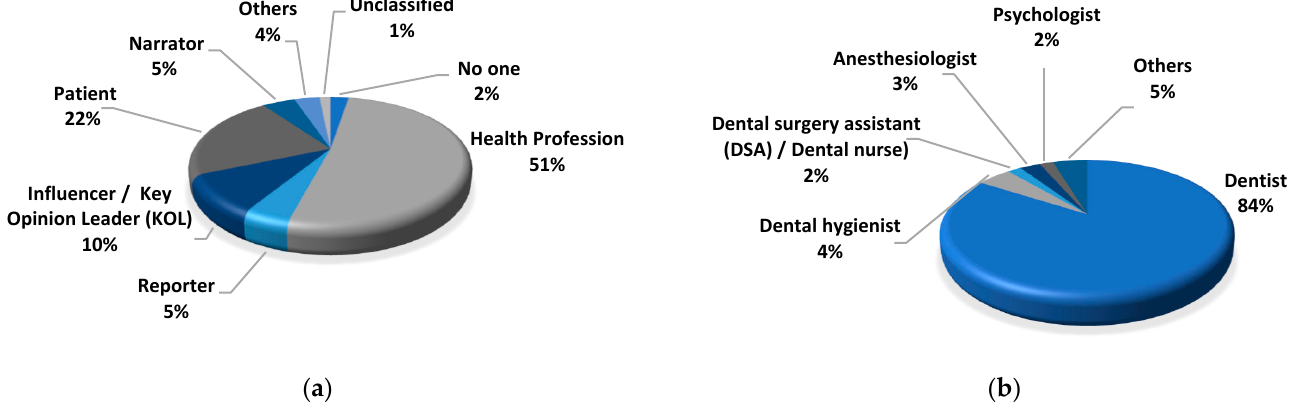
Figure 4. Percentage of informants included in YouTube videos: ( a ) percentage of informants in different categories; ( b ) percentage of health professional informants in different categories.